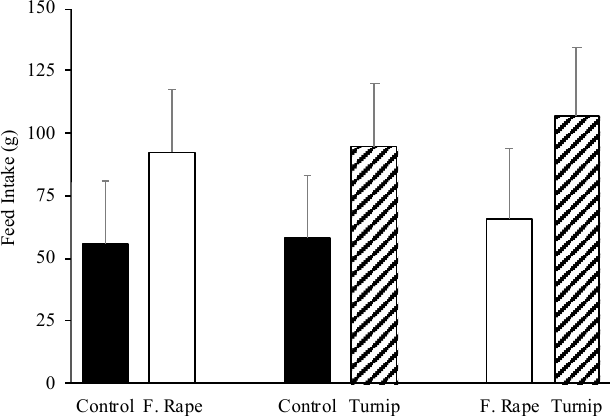
Figure 2. Pigs’ feed intake (g) of corn–soybean base diets (least squares means + standard error) with the inclusion of 15% of forage rape, turnip, or wheat middlings (control) when animals were offered a two-feeder preference test during 10 min.